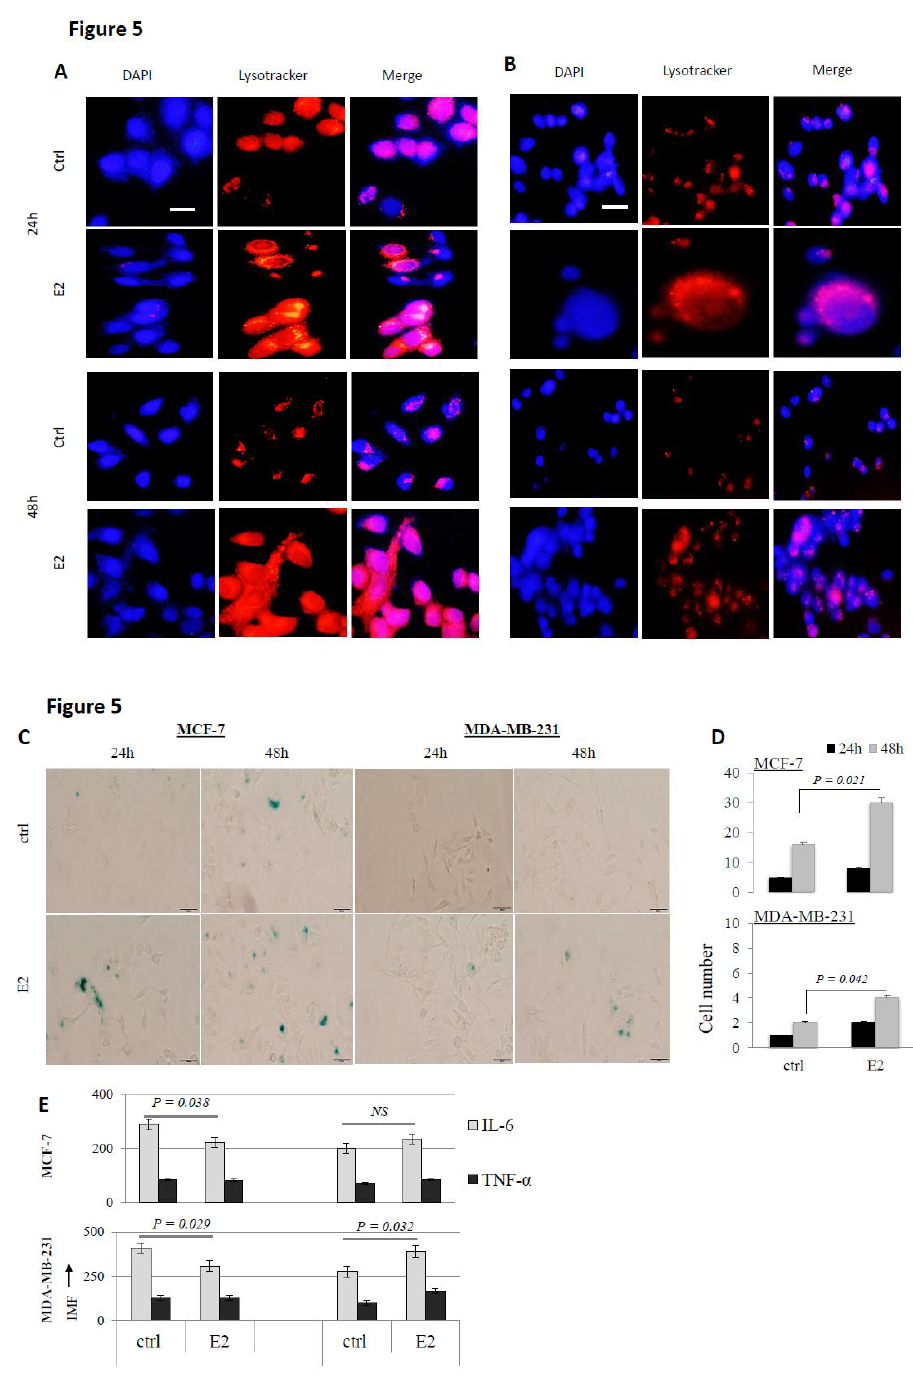
Figure 5. Functional assessment of autophagy in E2-treated cells. MCF-7 ( A ) and MDA-MB-231 ( B ) cells treated with 20 nM E2 or left untreated for 24 or 48 h were stained for DNA (DAPI; blue) or lysosomal accumulation (lysotracker; red). Data shown is representative of three independent experiments. ( C ) Qualitative assessment of senescence in MCF-7 and MDA-MB-231 cells treated with 20 nM E2 for 24 and 48 was done by observing the formation of green-metallic color following the addition of SA- β -Gal reagent. ( D ) Mean + SD of manually counted senescent MCF-7 and MDA-MB-231 cells at 24 and 48